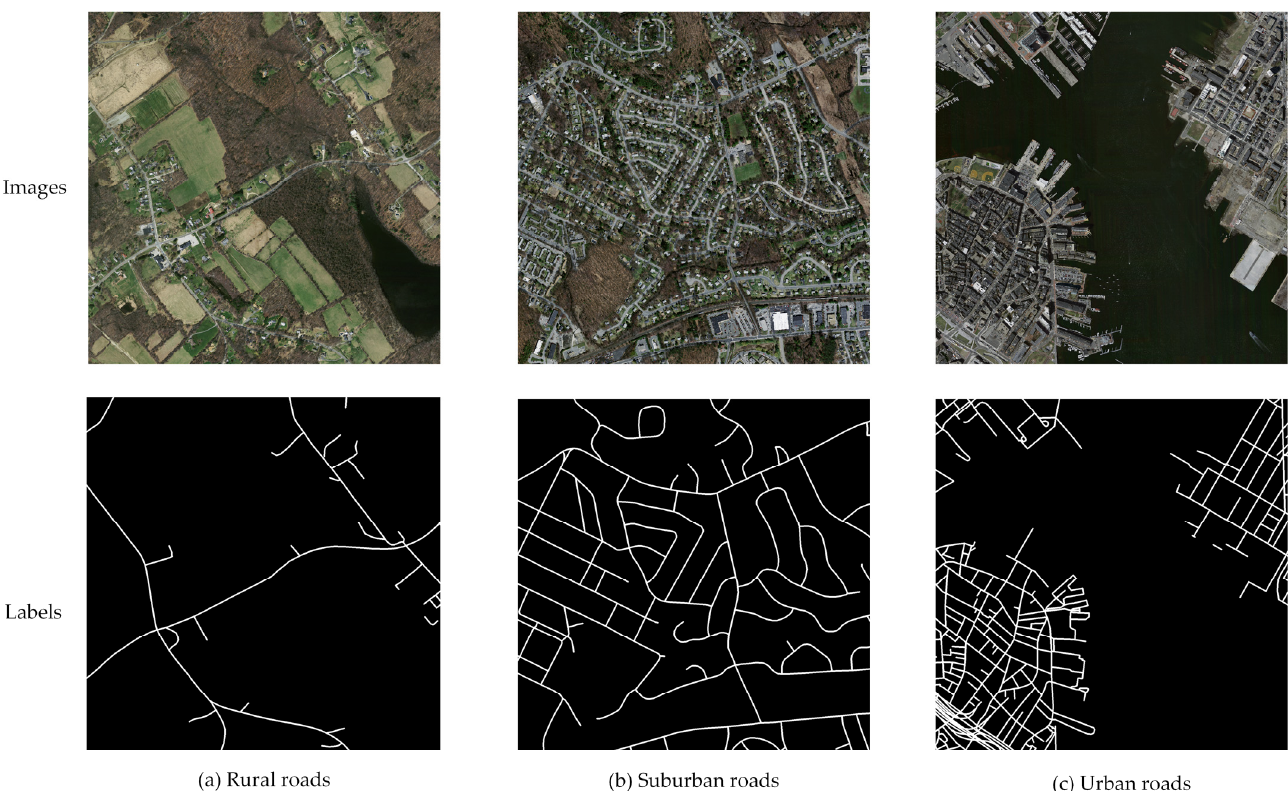
Figure 5. Typical images with roads in rural, suburban and urban areas in the Massachusetts roads dataset. ( a ) The rural roads; ( b ) The suburban roads; ( c ) The urban roads.